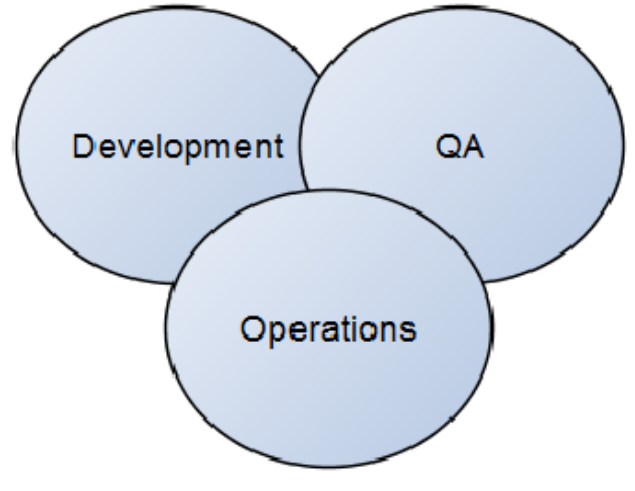
Fig. 4. DevOps work environment.